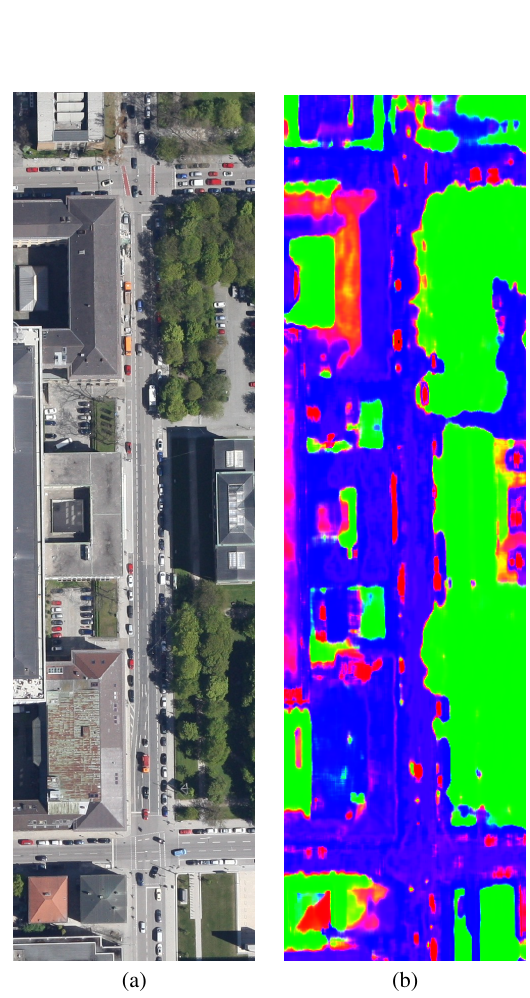
Figure 9: When the algorithm is applied to Fig.9 (a) we receive a result as it is shown in Fig.9 (b). The likelihoods k cand have been mapped to the RGB color space with red, green, blue for k car , k Vegetation , k Road , respectively. Other colors are a mixture of these base colors and state that the decision was not clear. Aimed objects were cars oriented in vertical